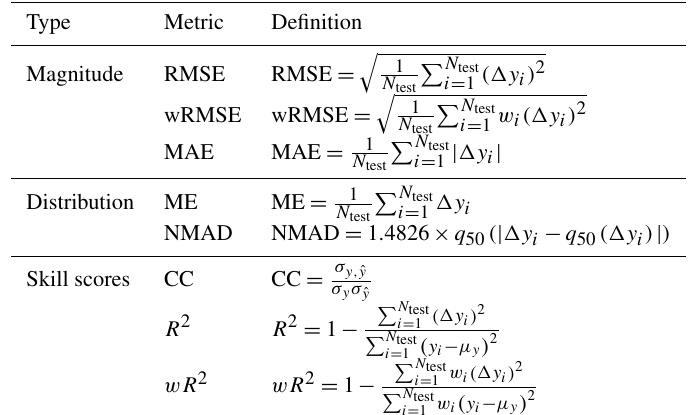
Table 2. Summary of metrics used in this work: y and ˆ y stand for reference value and predicted value, respectively; (cid:49)y i = ˆ y i − y i . µ y is the sample mean of y ; σ y and σ ˆ y are the sample standard deviations of y and ˆ y , respectively; σ y and ˆ y is the sample covariance between y and ˆ y , respectively; w i is the weight of regression residual determined by the frequency of corresponding target value which can be estimated using Gaussian kernel density